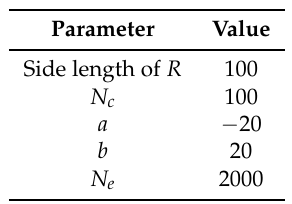
Table 3. Simulation configuration.